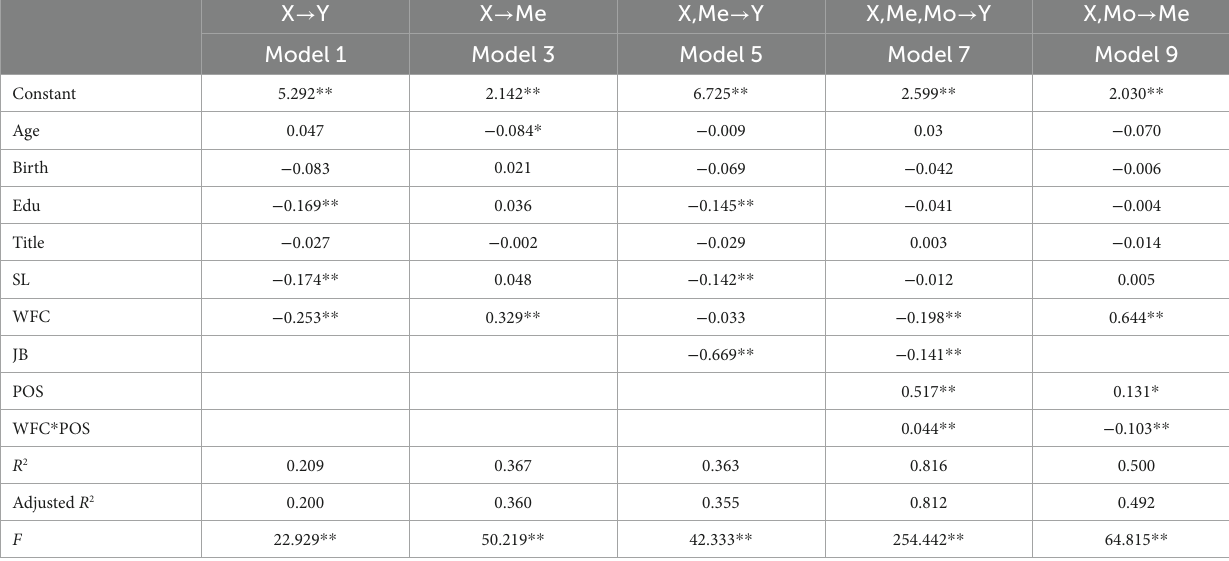
TABLE 3 Regression analysis results of main effect, mediating effect and moderating effect of WFC.